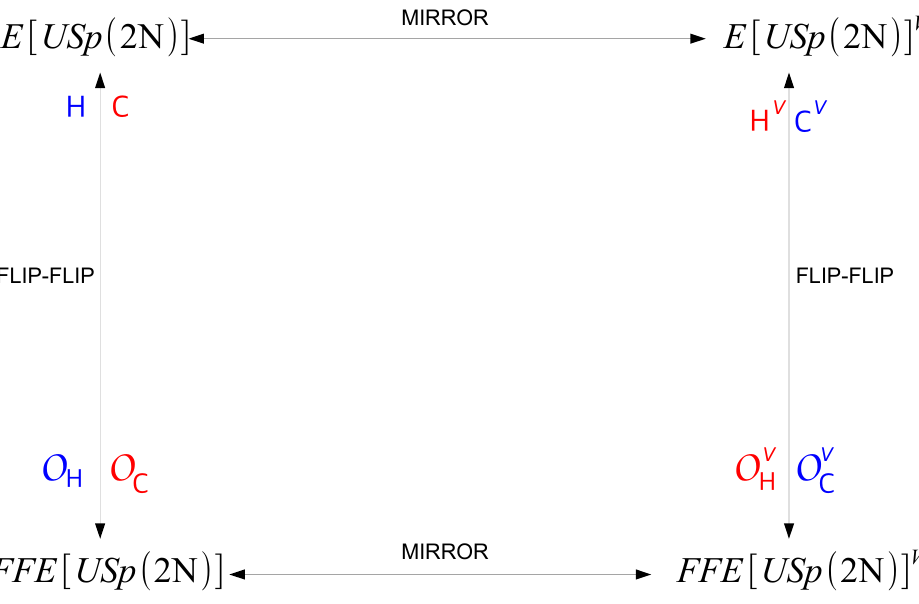
Figure 5 . Duality web for E [USp(2 N